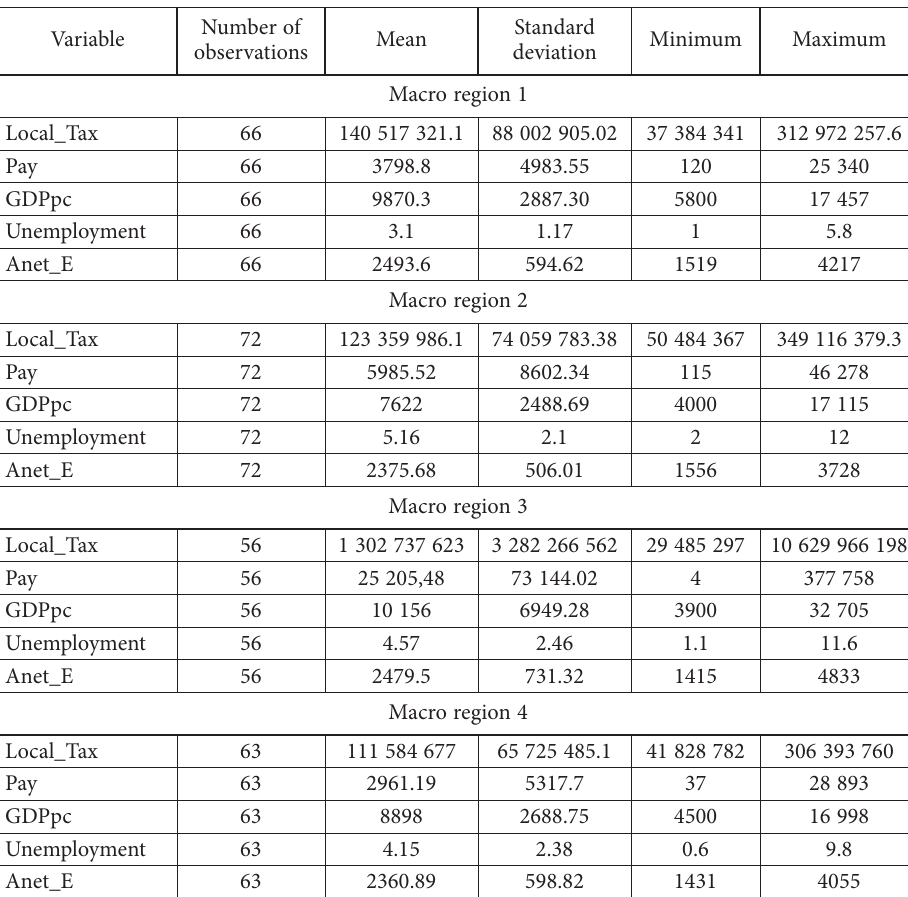
Table 2. Descriptive statistics of variables for Macro